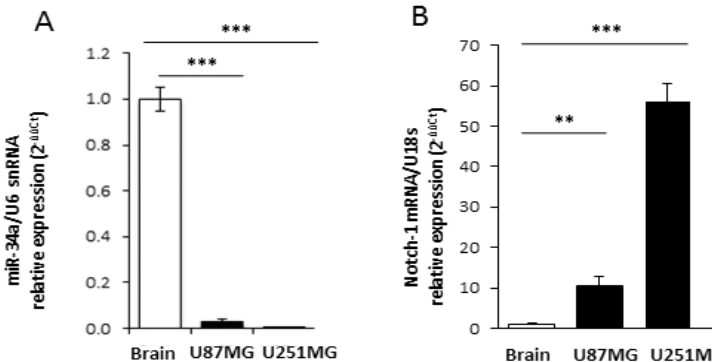
Figure 2. Expression of Notch-1 and miR-34a-5p in GBM cell lines and human brain. Real time RT-PCR analysis of miR-34a-5p ( A ) and Notch-1 ( B ) relative expression in U87MG or U251MG cell lines (black bars) compared to human normal brain (white bar). snRNA U6 and 18S were respectively used as the internal standard (** p < 0.01; *** p < 0.001; t -test).